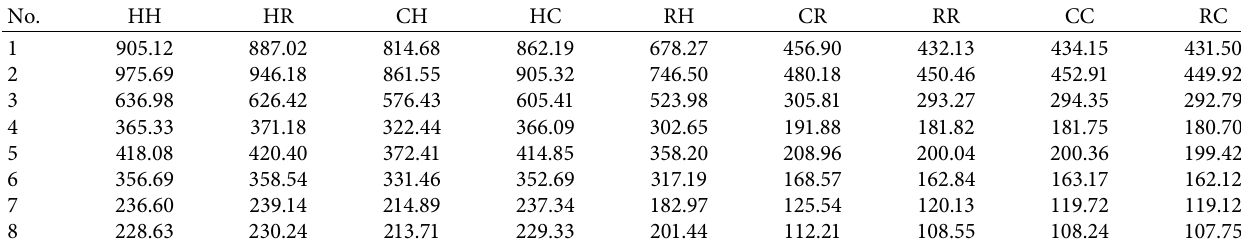
Table 6: Mean makespans of schedules returned by the LS algorithms for the SCP1 benchmark with cov � 90%. No. HH